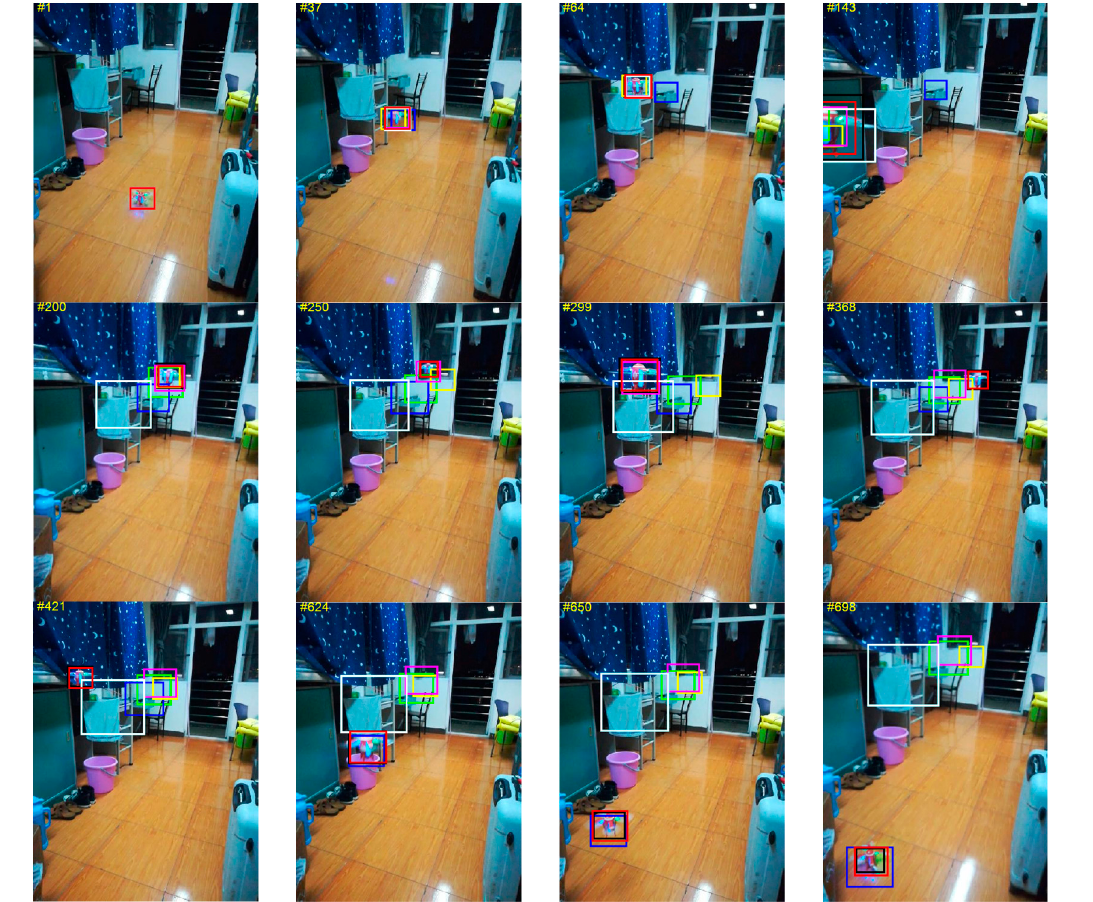
Figure 9. The qualitative experiment comparing the MACF (in red) with state-of-the-art trackers ECO-HC (in blue), BACF (in cyan), STC (in white), Staple (in green), SRDCF (in black), DAT (in yellow) and FDSST (in pink) on UAV video sequence with static background.